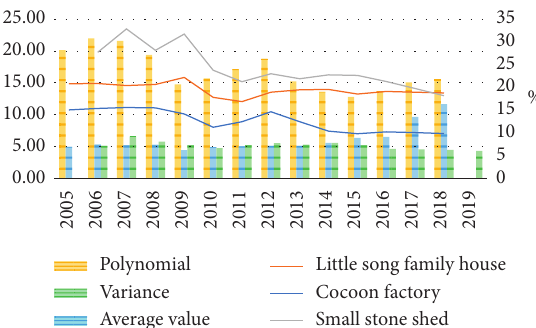
Figure 4: Analysis of prognostic